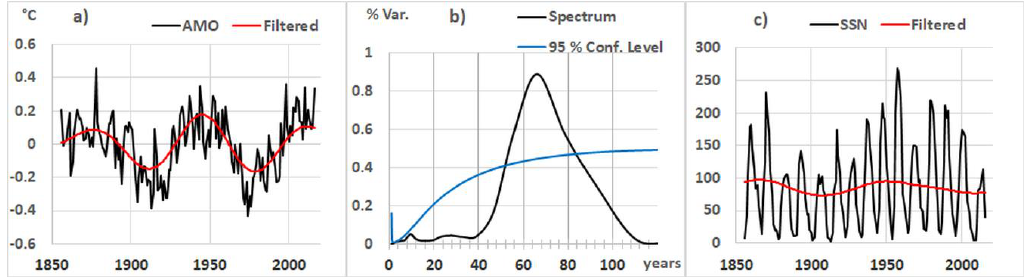
Figure 7. ( a ) De-trended AMO unfiltered and filtered with a bandpass filter within the 48 – 96 year band; ( b ) Fourier power spectrum of AMO from 1856 to 2016 and confidence spectrum assuming a red-noise with a lag-1 autocorrelation α = 0.68; ( c ) Sun Spot Number (SSN) unfiltered and filtered with the same bandpass filter as in ( a ).